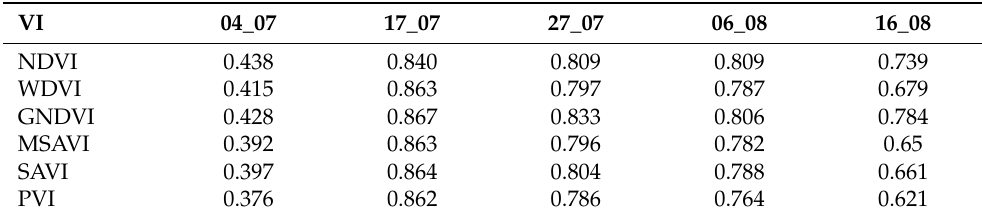
Table 15. The Pearson correlation coefficient between the single-date mean VI values and the recorded yield across all pilot